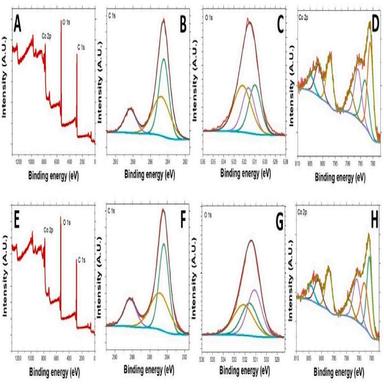
XPS survey spectra of pristine Co-BDC (A), after 5 catalytic/degradation cycles (E), and XPS detailed line scans of the pristine Co-BDC and after 5 catalytic/ degradation cycles (B, F) C1s, (C, G) O1s, and (D, H) Co2p.